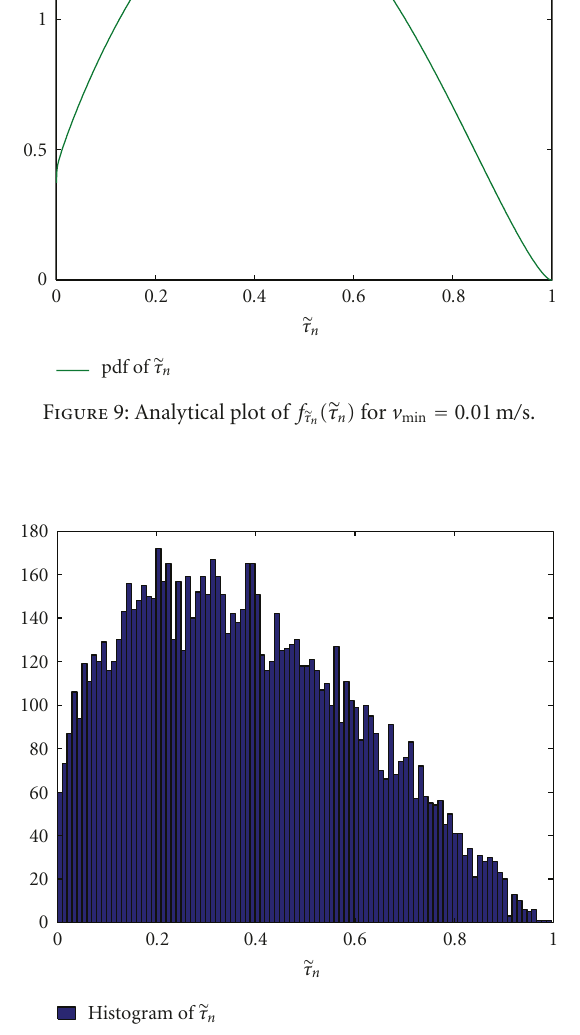
Figure 10: Histogram plot of (cid:9) τ n for v min = 0 . 01m / s .